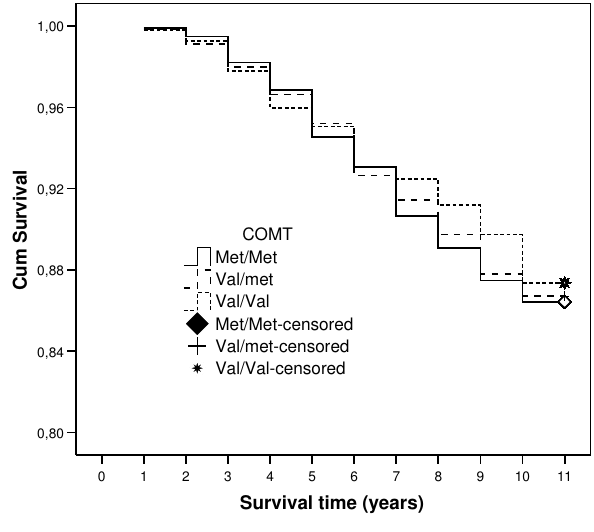
Figure 1 Survival curves for different genotypes. Log-rank test: p = 0.87.